Question: Describe this figure in one sentence.
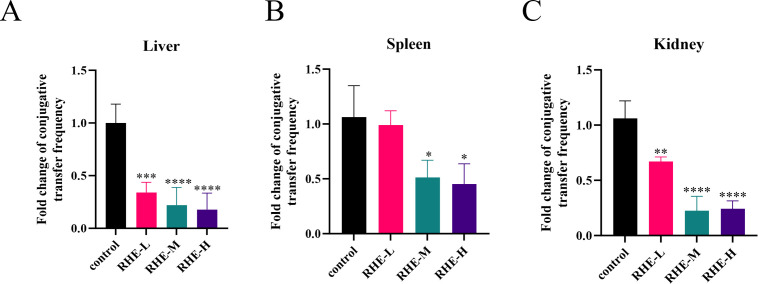
Answer: Rhein reduces the transfer frequency of the mcr-1 gene in the liver ( A ), spleen ( B ), and kidney ( C ) in vivo . RHE-L, RHE 2.5 mg/kg; RHE-M, RHE 5 mg/kg; and RHE-H, RHE 10 mg/kg. Data were presented as mean ± SD ( n = 6). Significant differences were evaluated by one-way ANOVA analysis and shown with * P < 0.05, ** P < 0.01, *** P < 0.001, and **** P < 0.0001.